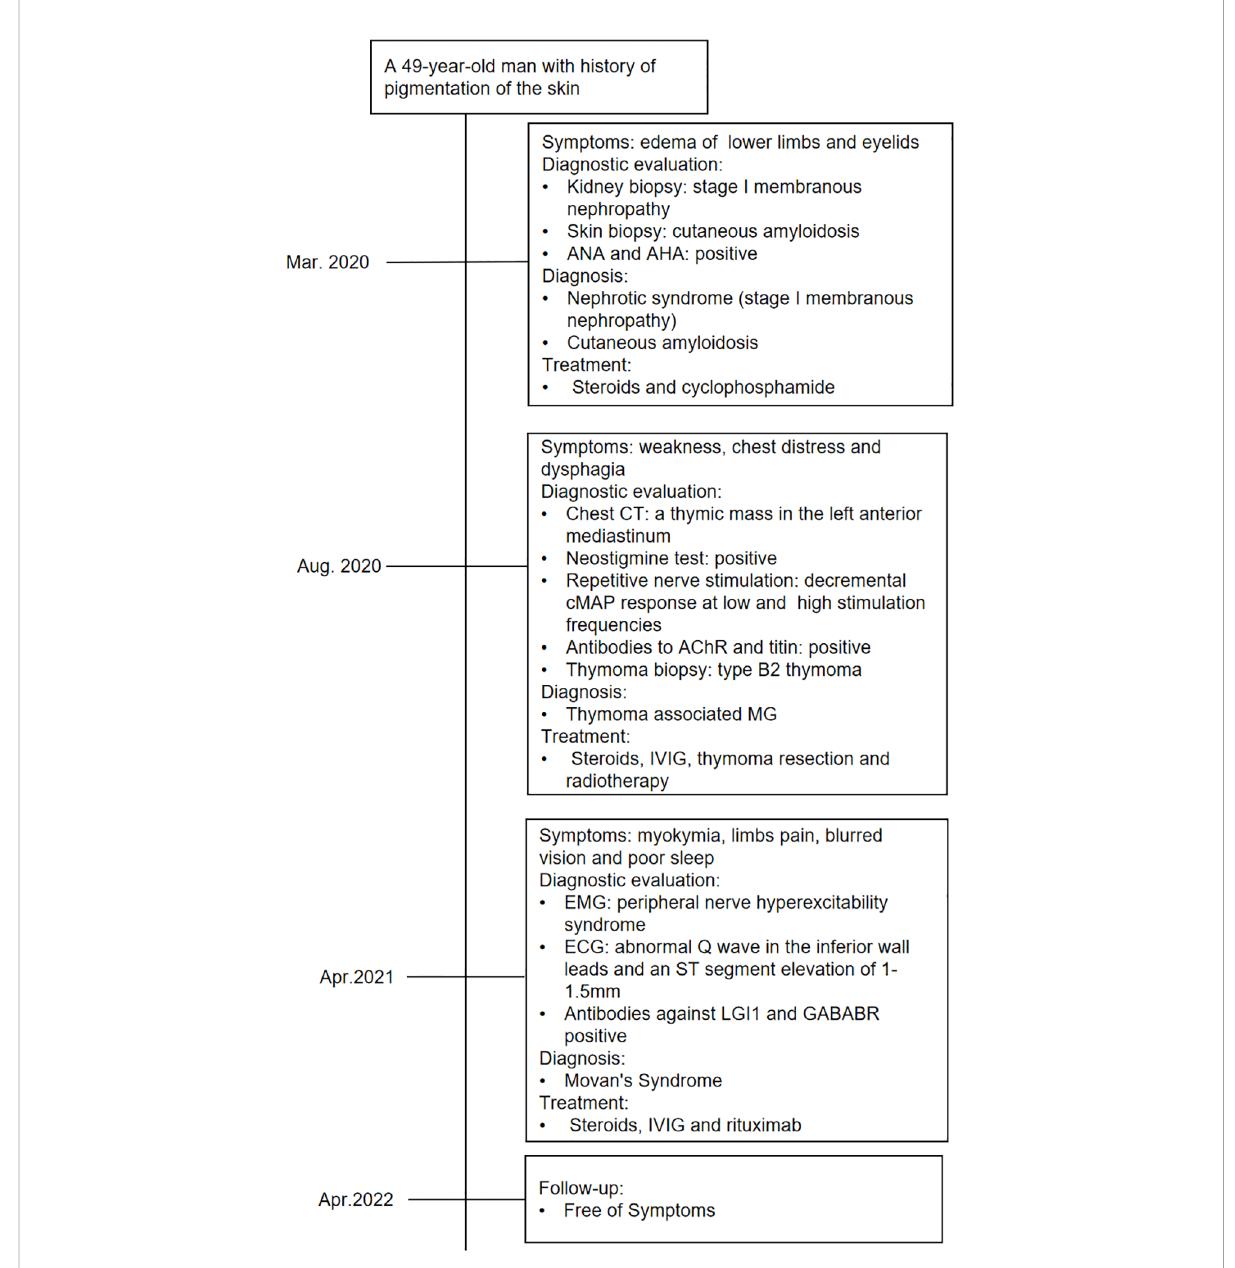
FIGURE 3 Timeline of the diagnosis, treatment, and outcome. CT, computed tomography; cMAP, compound muscle action potential